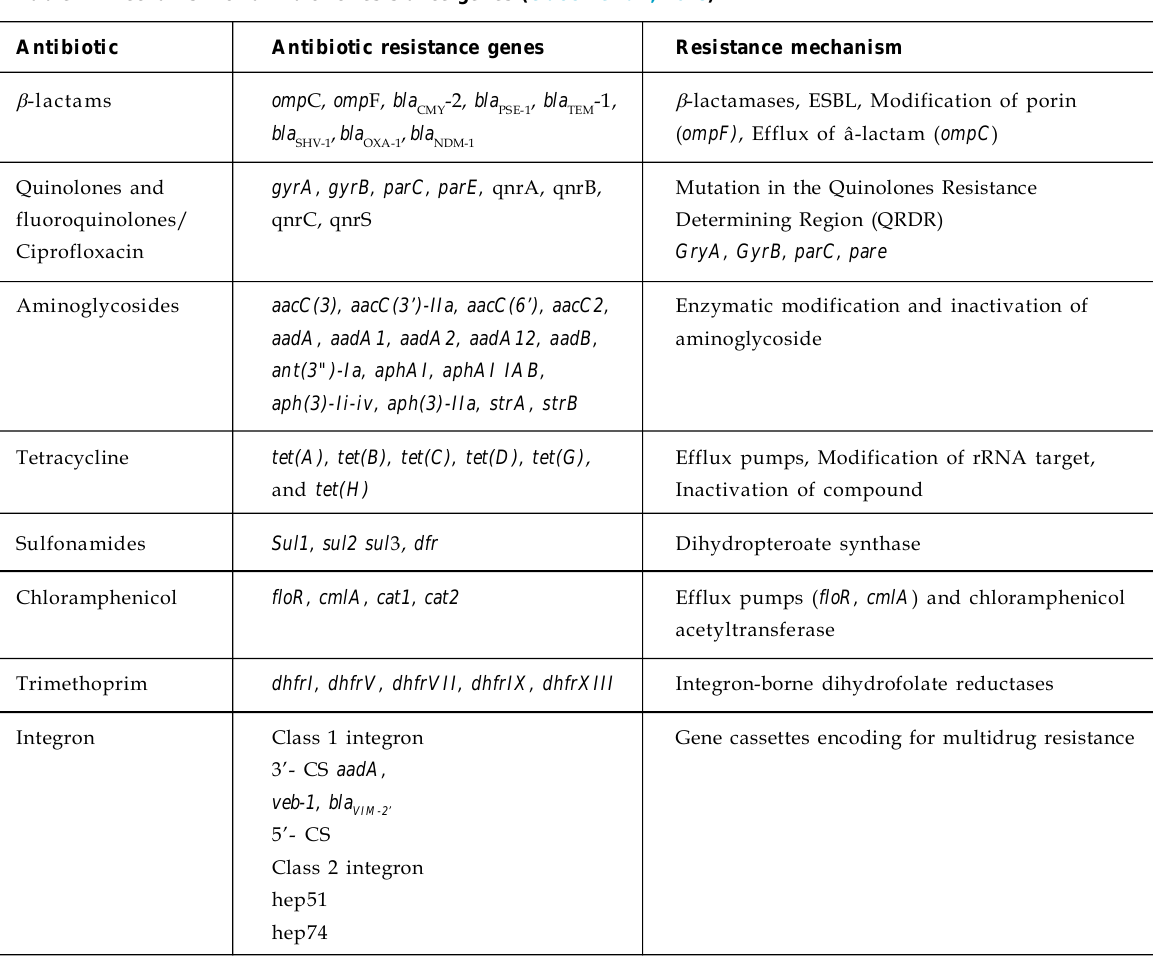
Table 2: Mechanism of antibiotic resistance genes (Odoch et al ., 2018) Antibiotic Antibiotic resistance genes Resistance